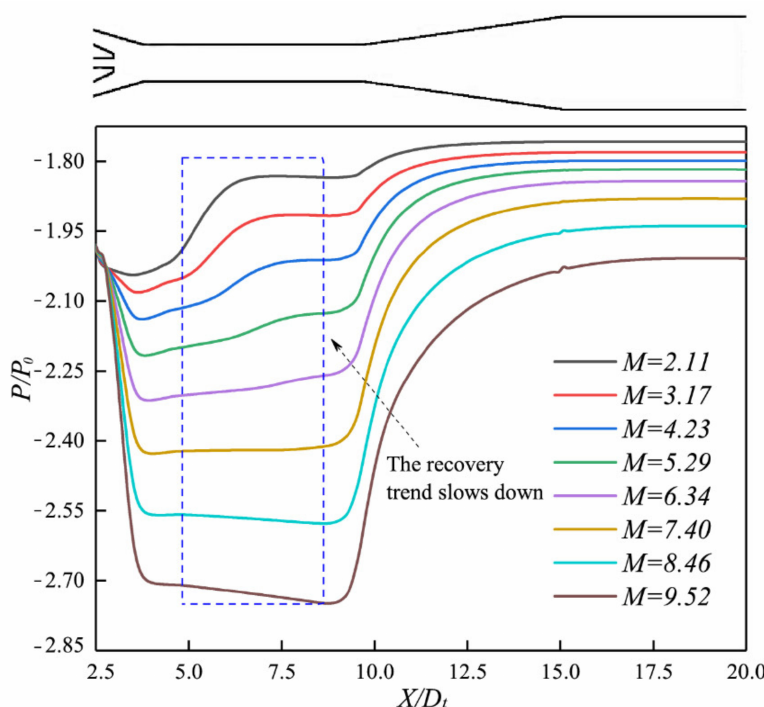
Figure 5. Axial pressure distribution from nozzle inlet to exit ( M = 2.11, 3.17, 4.23, 5.29, 6.34, 7.40, 8.46,